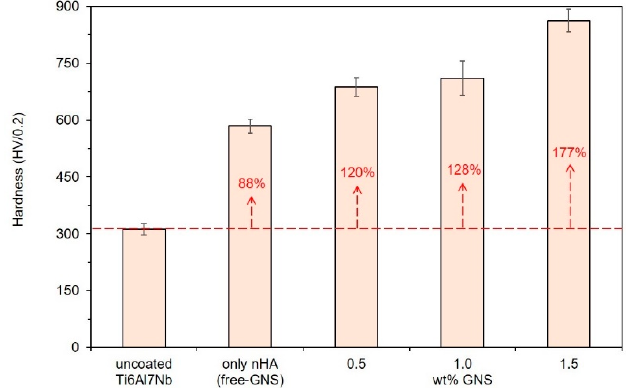
Figure 6. Microhardness results of the nHA/GNS hybrid coatings.